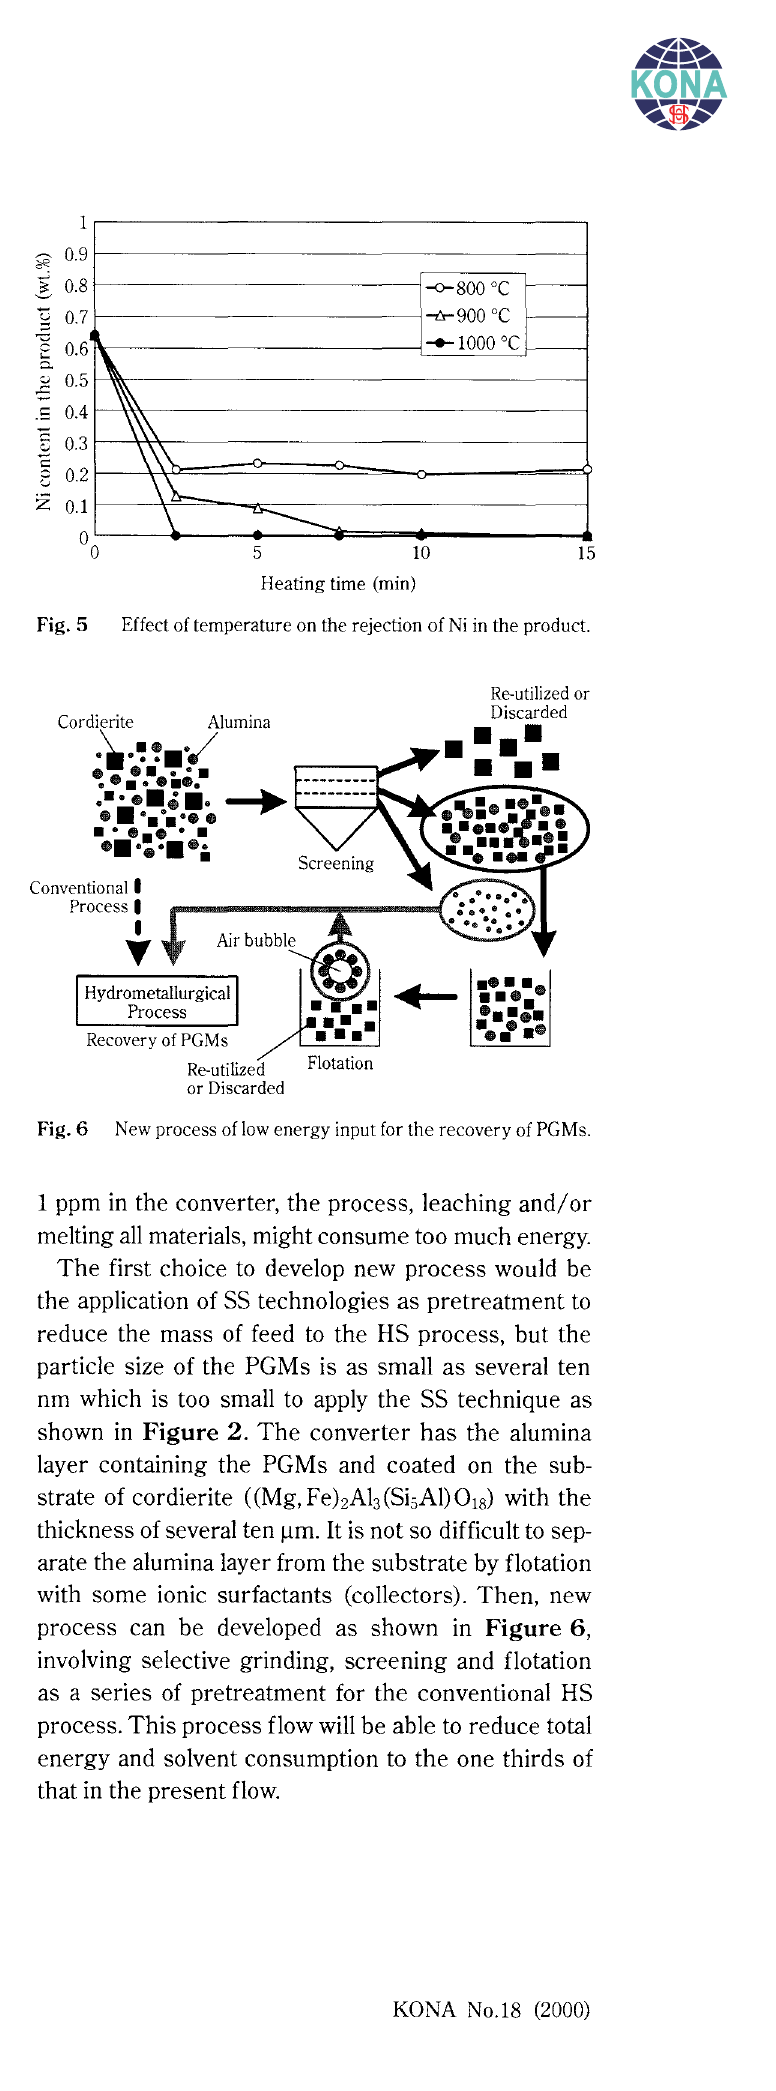
Fig. 5 Effect of temperature on the rejection of Ni in the product.